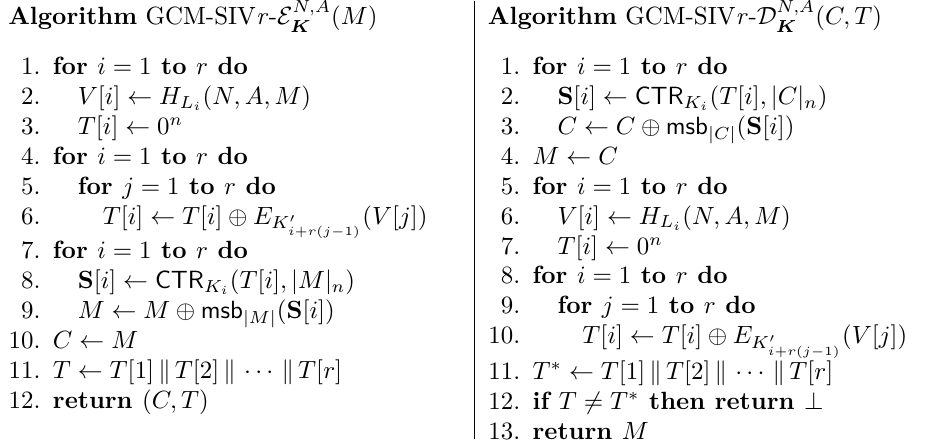
( M ) Algorithm GCM-SIV r - D N,A K